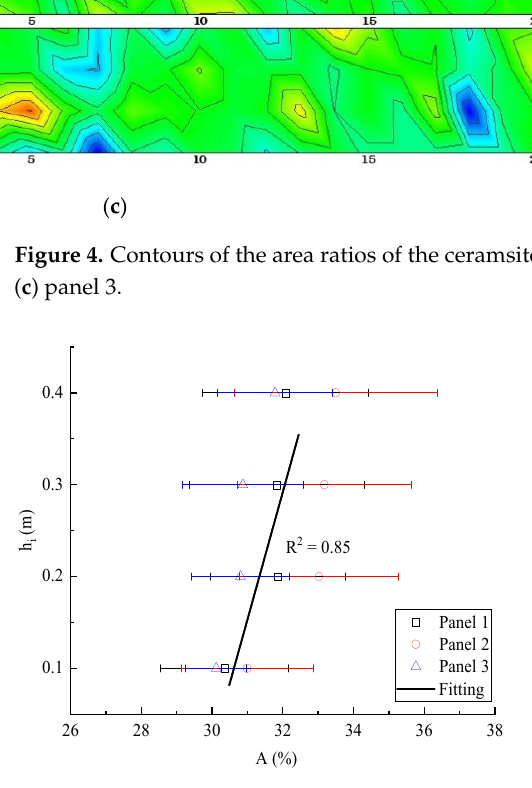
Figure 5. Relationship between proportion of ceramsite area and height.